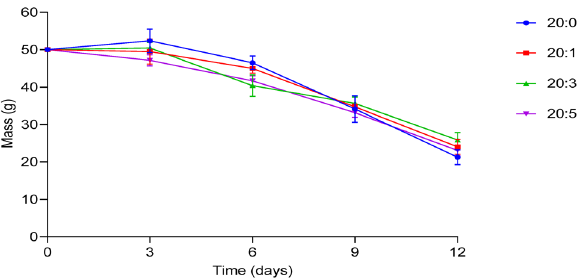
Figure 5. Degradation curve of the starch:keratin bio-composite films from a 12-day burial in soil. Results are means ± SD of triplicate determinations. Note: 20:0, 20:1, 20:3, and 20:5 = starch/keratin ( v / v ). Chart was drawn using GraphPad prism 8.0 software (GraphPad Software Inc., San Diego, California), https:// www. graph pad. com/ scien tific- softw are/ prism.